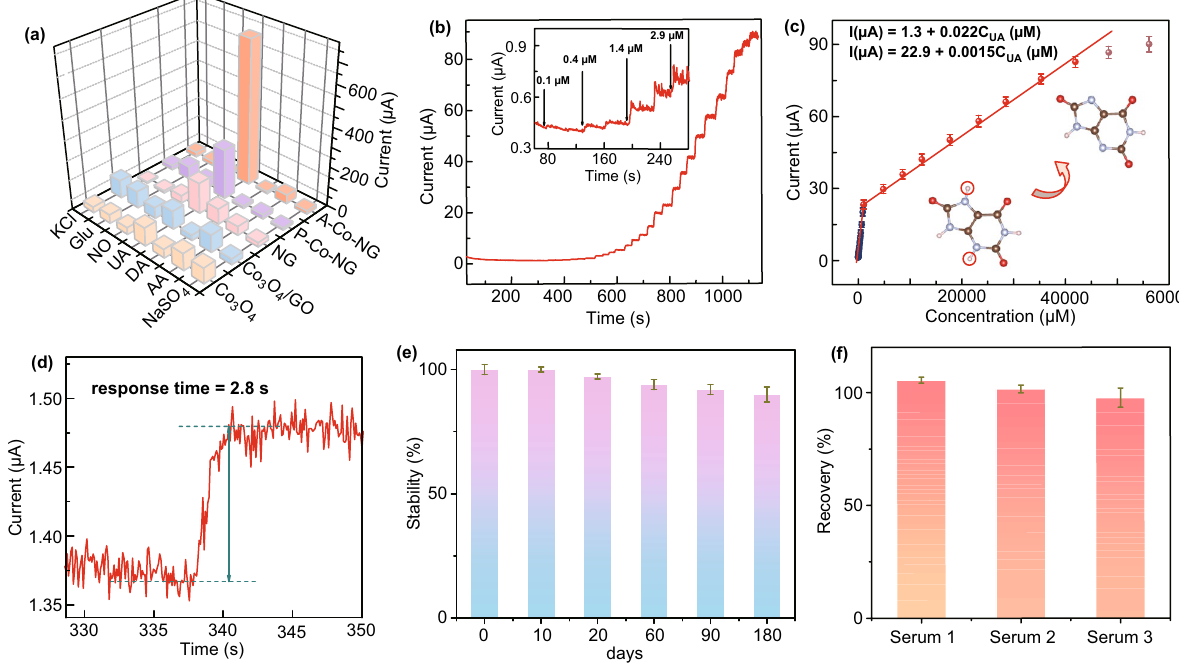
Fig. 4 a Histogram of selectivity for UA detection of A–Co–NG, P–Co–NG, NG, Co 3 O 4 /GO and Co 3 O 4 ; b Amperometric I − t curve of A–Co– NG upon continuous injection of different concentrations UA at an applied potential of 0.3 V versus SCE in 0.1 M NaOH (pH = 13); c Calibra- tion plots of the A–Co–NG for UA determination with two linear ranges; d Amperometric I−t Response time of the A–Co–NG for UA determi- nation; e Stability of A–Co–NG for UA detection with a long lifetime; f Recovery investigation of A–Co–NG performed by adding standard UA in human serum